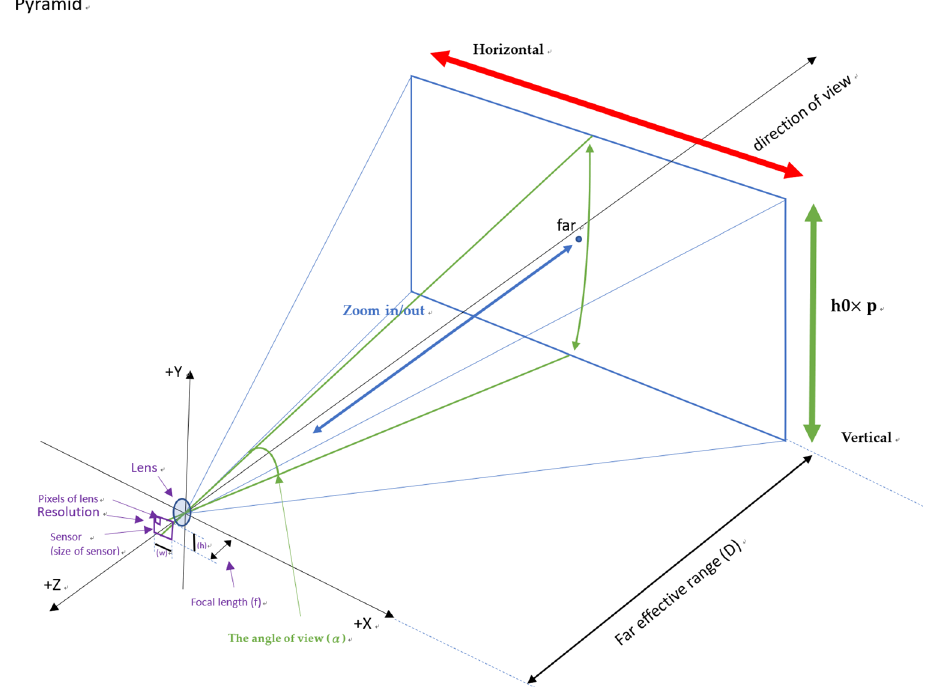
Figure 3. An explanatory diagram of related names of CCTV camera 3D FOV (modified